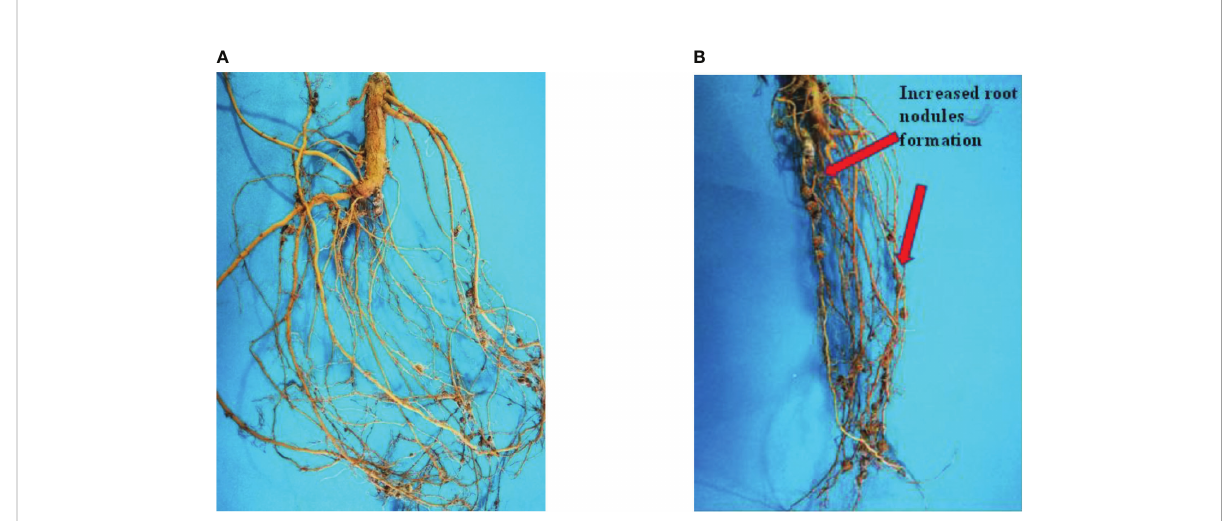
FIGURE 11 Effects of different GO NPs treatments on root nodules of mungbean plants. (A) = C= without GO NPs application (control); (B) = T4= 1200